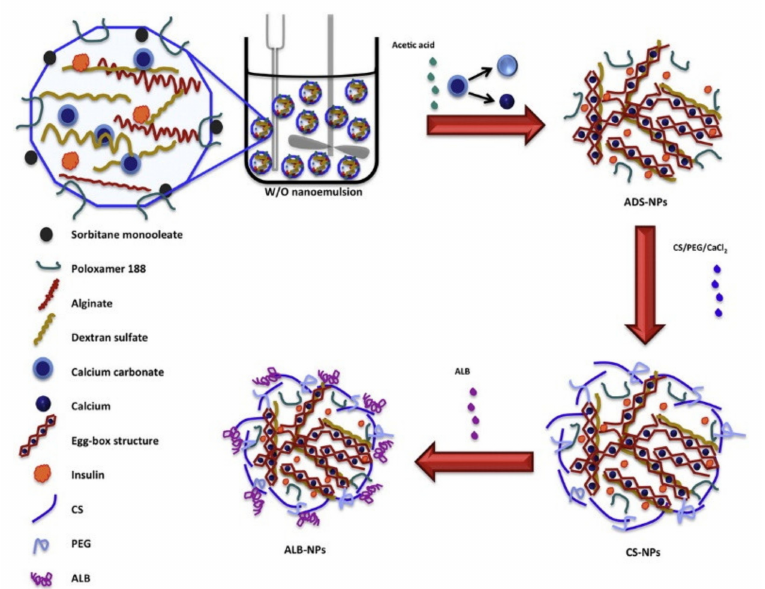
Figure 15. Schematic representation of the emulsification/internal gelation technique used to prepare the CS and albumin coated insulin-loaded alginate/dextran NPs [116]. Reproduced with permission from Elsevier